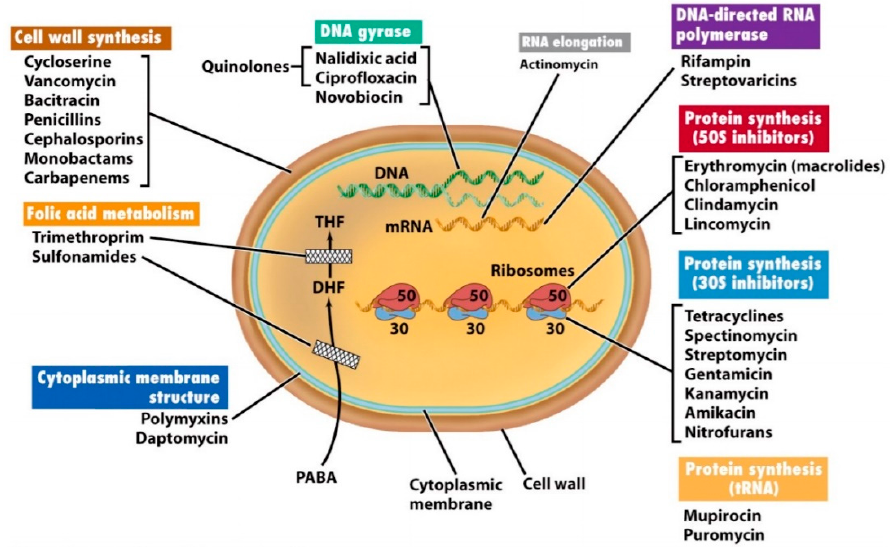
Figure 1. Antibiotic modes of action on bacteria (used with permission from [121]).